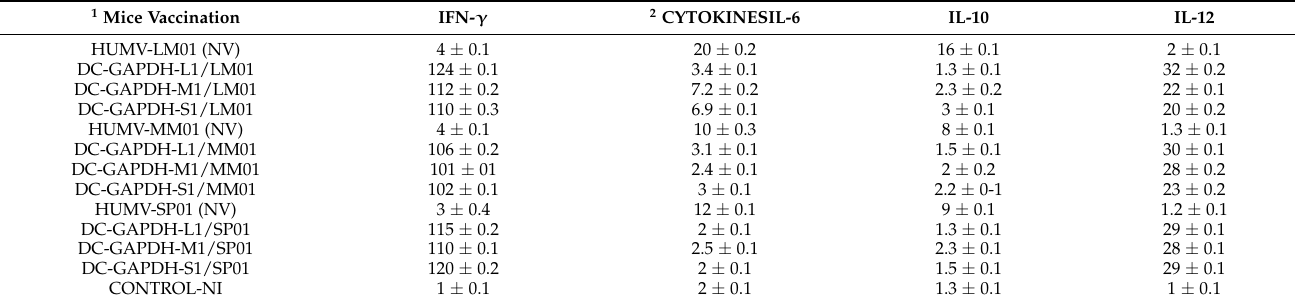
Table 2. Specific immune responses elicited after vaccination of mice with DC-GAPDH peptides and challenge with LM (HUMV-LM01), MM (HUMV-MM01) or SP